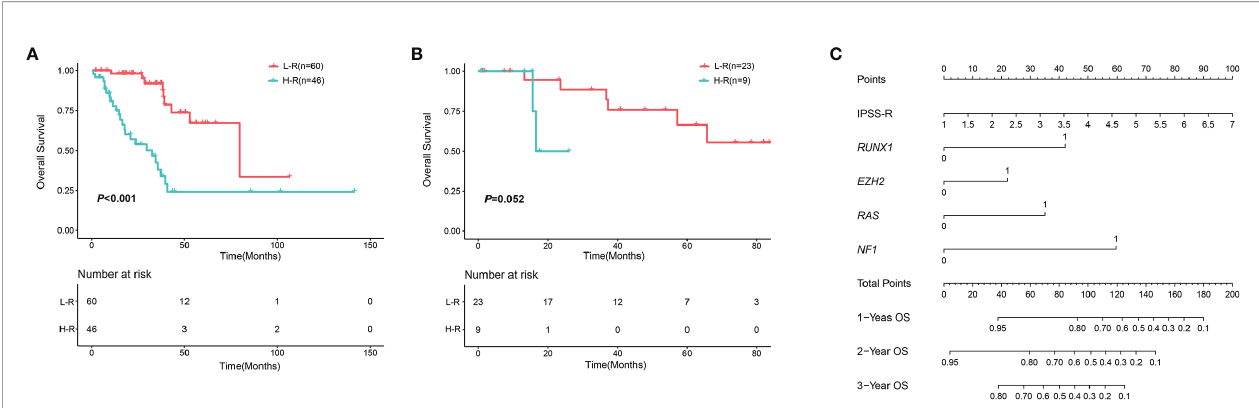
FIGURE 4 | OS in different risk groups according to the novel scoring model. (A) OS in the experimental cohort. (B) OS in the validation cohort. (C) Nomogram for MDS patients with SF3B1 mutation. An individual ’ s value is located on each variable axis, and a line is drawn upward to determine the points received for each variable. Corresponding points for each variable: IPSS-R scored as regular; RUNX1 mutation scored 1; EZH2 mutation scored 1; KRAS/NRAS mutation scored 1; NF1 mutation scored 1; 0 for other conditions.